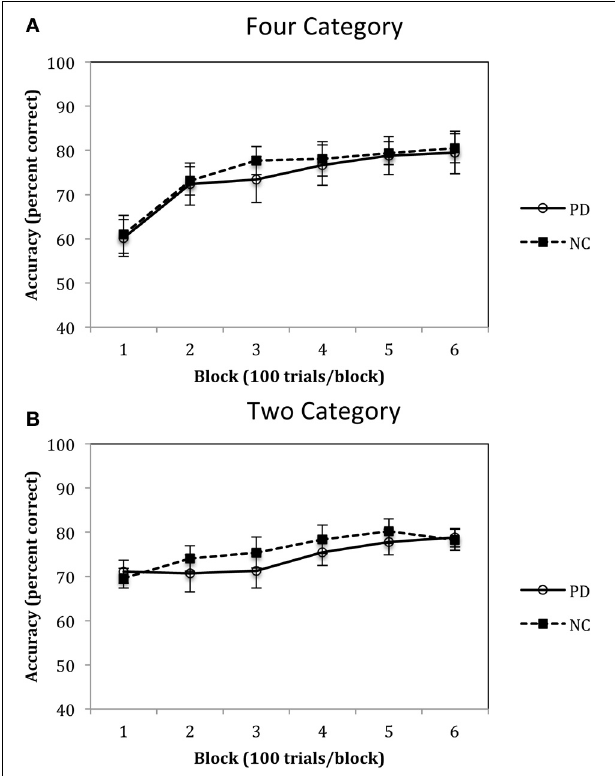
FIGURE 5 | Accuracy rates for PD patients and NC participants (A) Four Category and (B) Two Category conditions in Experiment 1. (Error bars are in standard error of the mean).